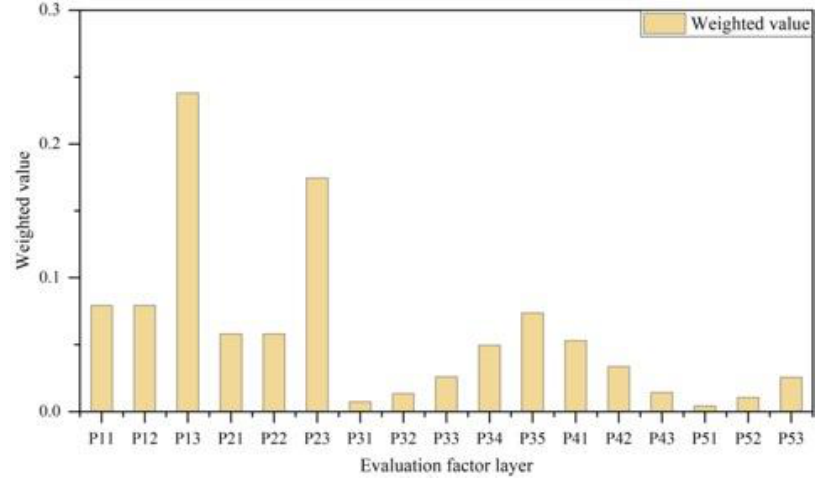
Figure 4. Final combined weights.